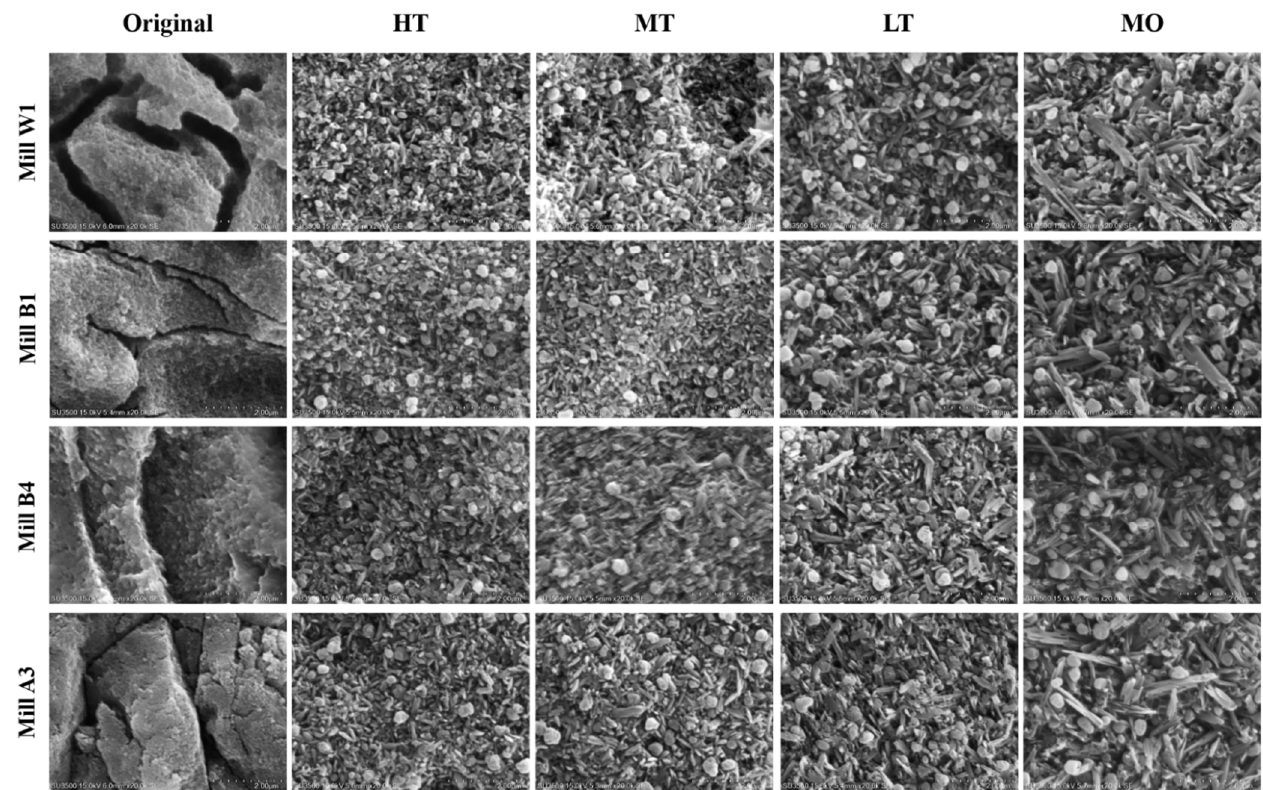
Figure 5. SEM images showing the microstructure of the Amber Mill ceramics at four different translucency extents and colors.